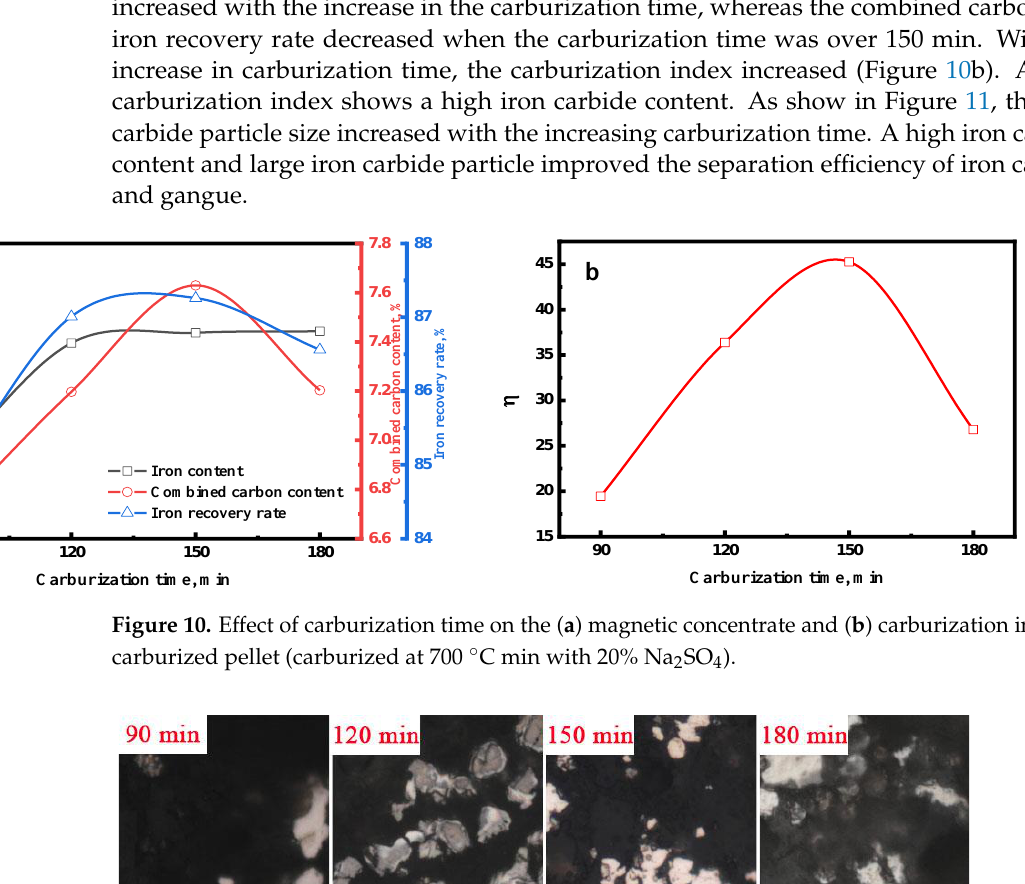
Figure 12. Effect of acetic acid concentration on the acid leaching concentrate (carburized at 700 °C for 150 min with 20% Na 2 SO 4 ; leached at 70 °C for 60 min). It is found from Figure 13 that the gangues, such as CaCO 3 , Ca 2 SiO 4 , CaSO 4 , Na 2 Si 3 O 7 , and Na 1.65 Al 1.65 Si 0.35 O 4 , were produced during the carburization process. In addition to these gangues, a small amount of iron carbide remained in tailing. The XRD results of acid leaching concentrate show that the diffraction peak intensities of CaCO 3 , Na 2 Si 3 O 7 , Na 1.65 Al 1.65 Si 0.35 O 4 , Ca 2 SiO 4 , Fe 3 C, and Fe 5 C 2 significantly decreased, whereas the diffraction peak intensities of C and CaSO 4 increased, especially C. It is clearly found that CaCO 3 , Na 2 Si 3 O 7 , Na 1.65 Al 1.65 Si 0.35 O 4 , and Ca 2 SiO 4 dissolved in the acetic acid, while free carbon and CaSO 4 did not dissolve in the acetic acid. It is speculated that H + reacts with CaCO 3 , Ca 2 SiO 4 , Na 2 Si 3 O 7 , and Na 1.65 Al 1.65 Si 0.35 O 4 (Equations (9) – (12)) during the acid leaching pro- cess. The different solubility of these gangues and free carbon in acetic acid enhanced the separation efficiency of free carbon and gangue significantly. The carbon phase can be easily enriched by removing Ca, Si, Al, and Na in the form of sodium aluminosilicates, sodium silicate, dicalcium silicate, and calcium carbonate by acid leaching treatment. In addition, the XRD results of acid leaching concentrate show that the diffraction peak 0